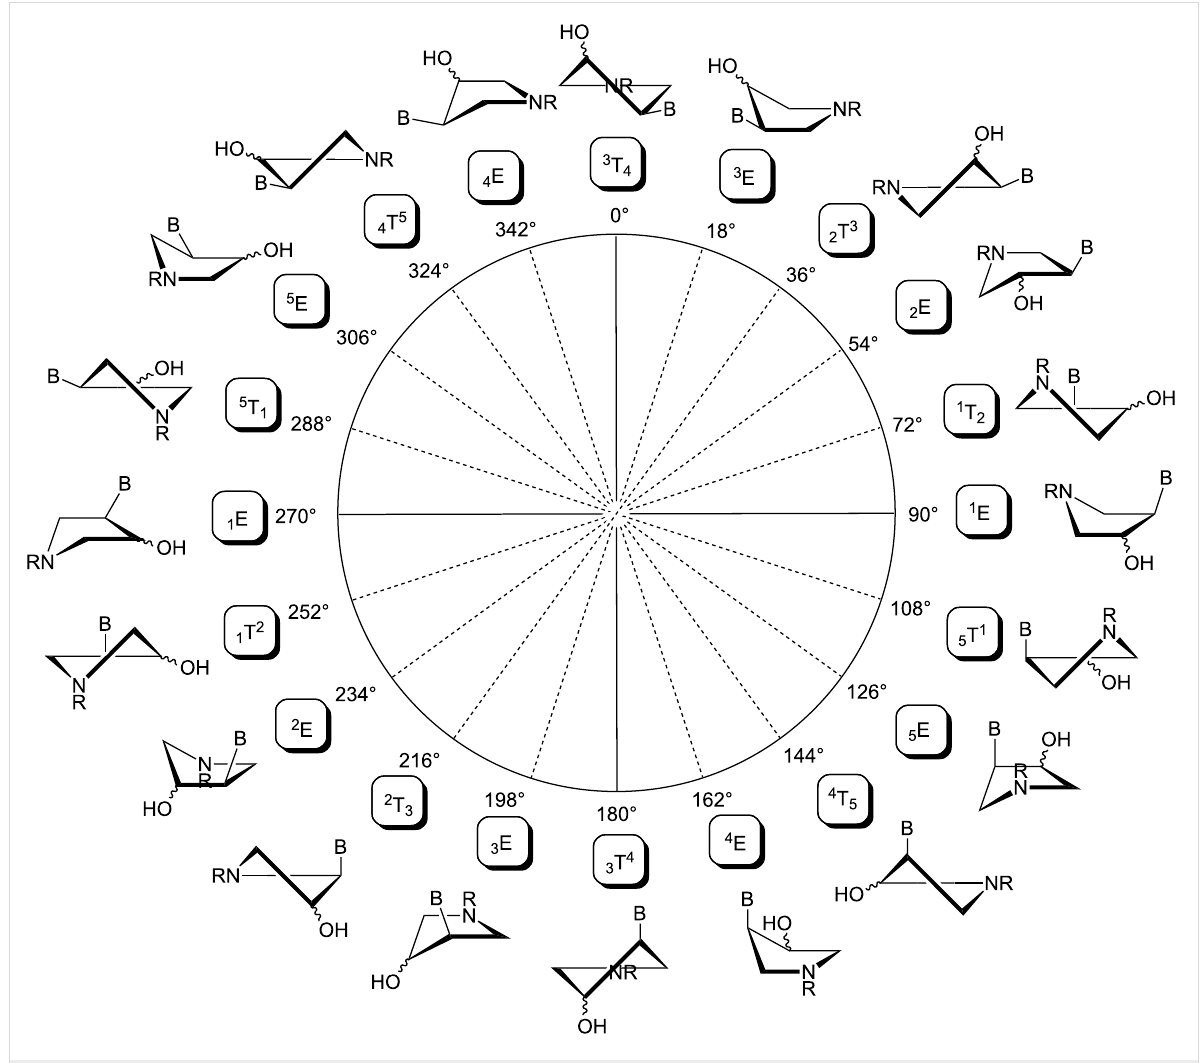
Figure 11: The pseudorotation pathway of the pyrrolidine ring in the compounds studied. The sign B stands for a nucleobase (thymin-1-yl or adenin- 9-yl) and R means a phosphonomethyl or phosphonoformyl moiety.